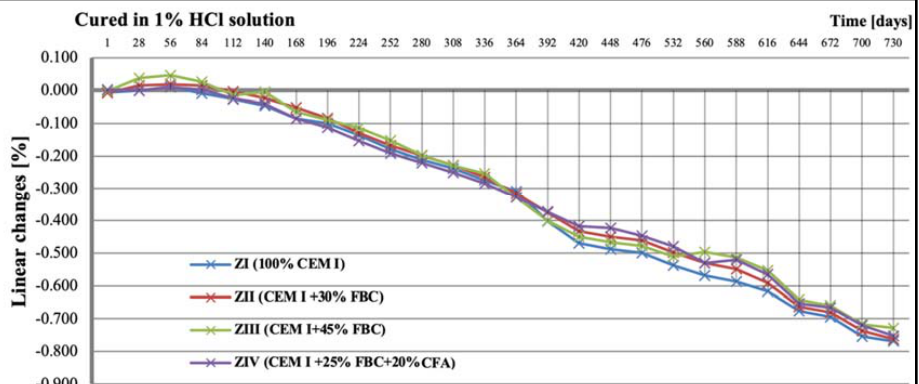
Figure 11. Linear changes of mortars cured in water for 730 days.